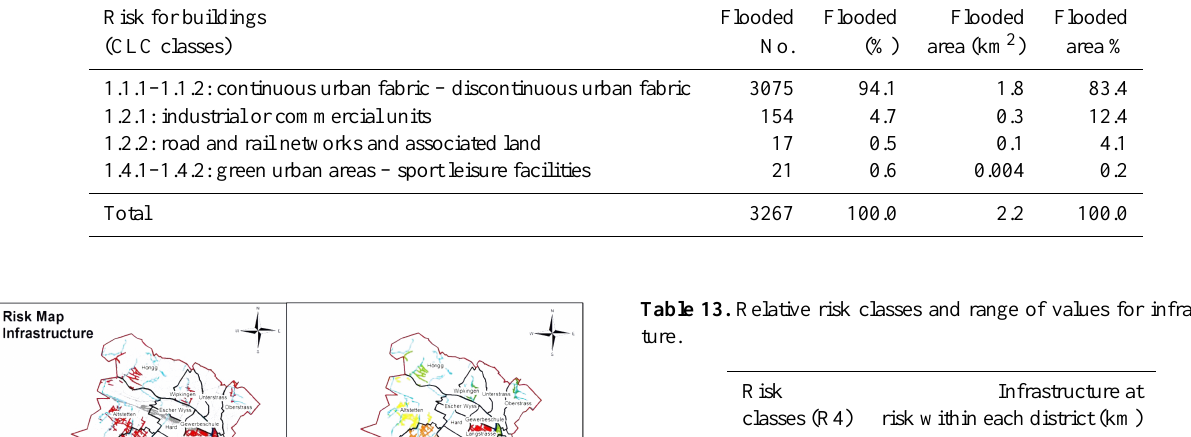
Table 12. Statistics on the risk for buildings for different CLC classes. Risk for buildings